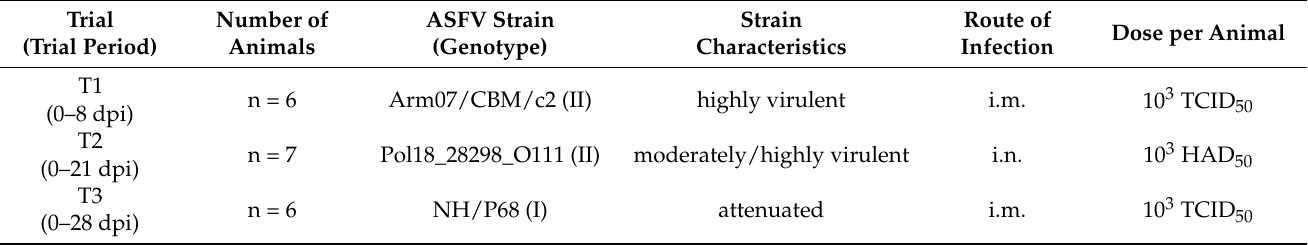
Table 1. Experimental settings